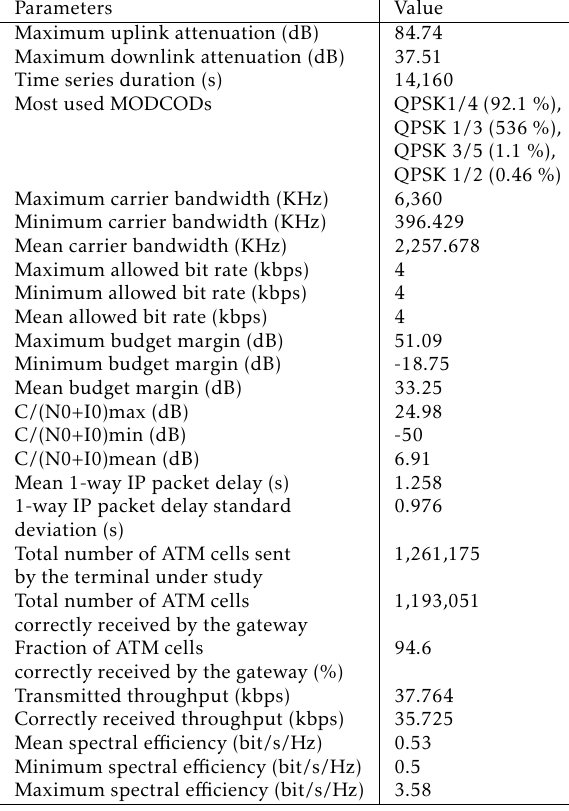
Table 2. Return link performance report for UTD terminals in V band